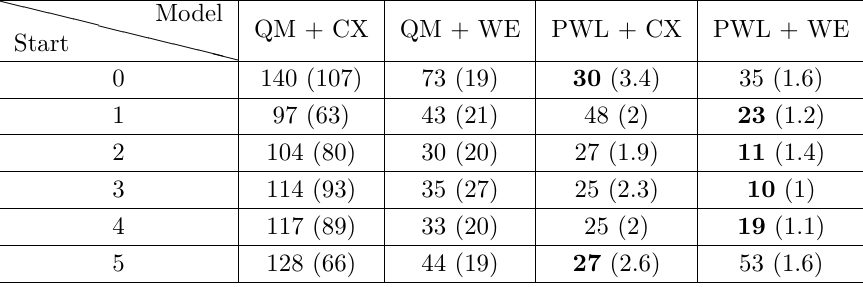
Table 10: Solving times for Camellia over 7 rounds depending on the starting round and modeling. Timings are given in seconds, where the number in parenthesis is the time spent to prove only the balanced bits. Best total time for each starting round is in bold.